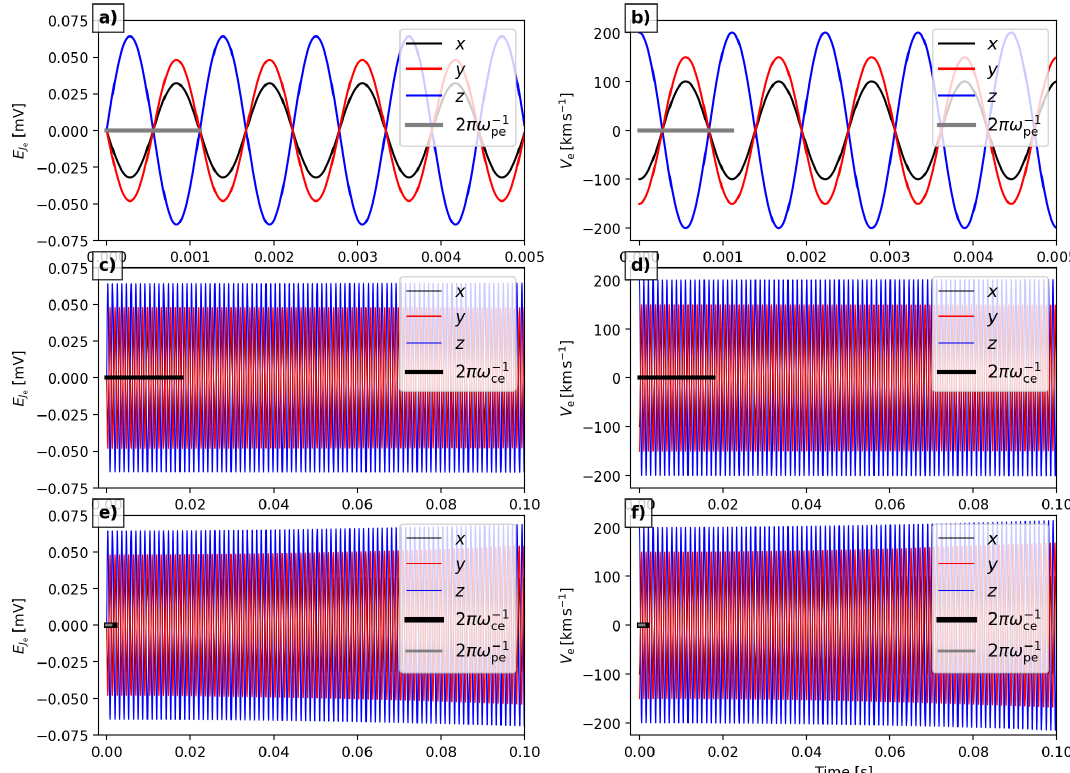
Figure 3. Graphs of solver stability in relation to electron plasma oscillation and gyromotion in a single-cell simulation. Note the different time axes used. (a, c, e) Oscillation electric field E J components. (b, d, f) Electron bulk velocity V e components. (a, b) Graph values in e relation to the electron plasma oscillation period (indicated with a thick grey bar) and (c, d) in relation to the electron gyroperiod (indicated with a thick black bar), with a background magnetic field of B = 20nT. (e, f) A simulation with a magnetic field of B = 200nT, resulting in the gyromotions and oscillatory motions interacting over multiple periods.